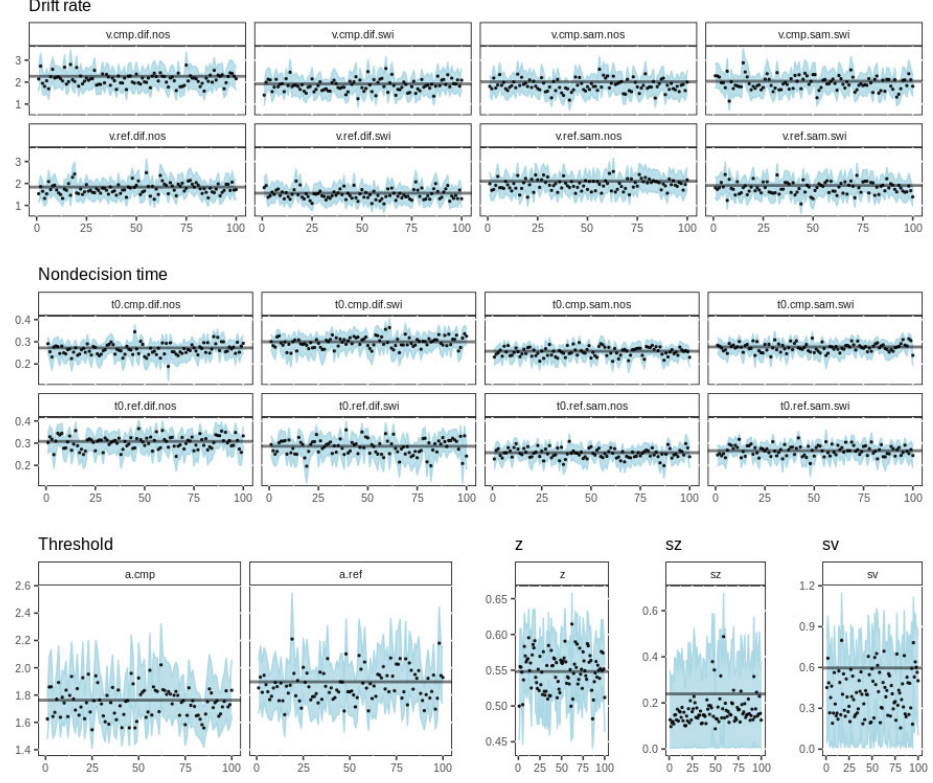
Figure A1. Parameter recovery for the top model. Each panel shows the recovered parameter values for 100 synthetic subjects (black dots) plotted against the known data-generating value (horizontal lines). The shaded region represents the 95% credible interval surrounding the recovered value. Note: z = starting point, sz = starting point variability, sv = drift rate variability.